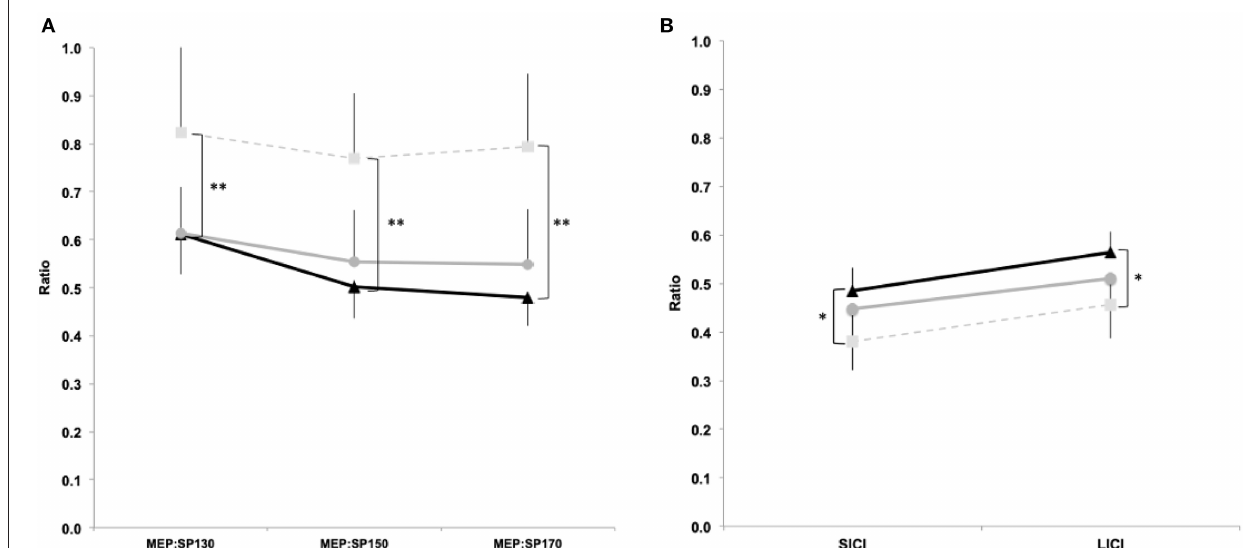
FIGURE 3 | TMS single and paired pulse data. MEP:cSP ratios between groups for 130%, 150% and 170% aMT (a) and SICI (3 ms) and LICI (100 ms) paired pulse (b) . Light squares/dashed line represent controls, grey circles/solid line represent ’asymptomatic’ group, and black triangles/solid line represent ’symptomatic’ group. (Data expressed as group mean ± 95%CI; ns - not significant; * p < 0.05; ** p <